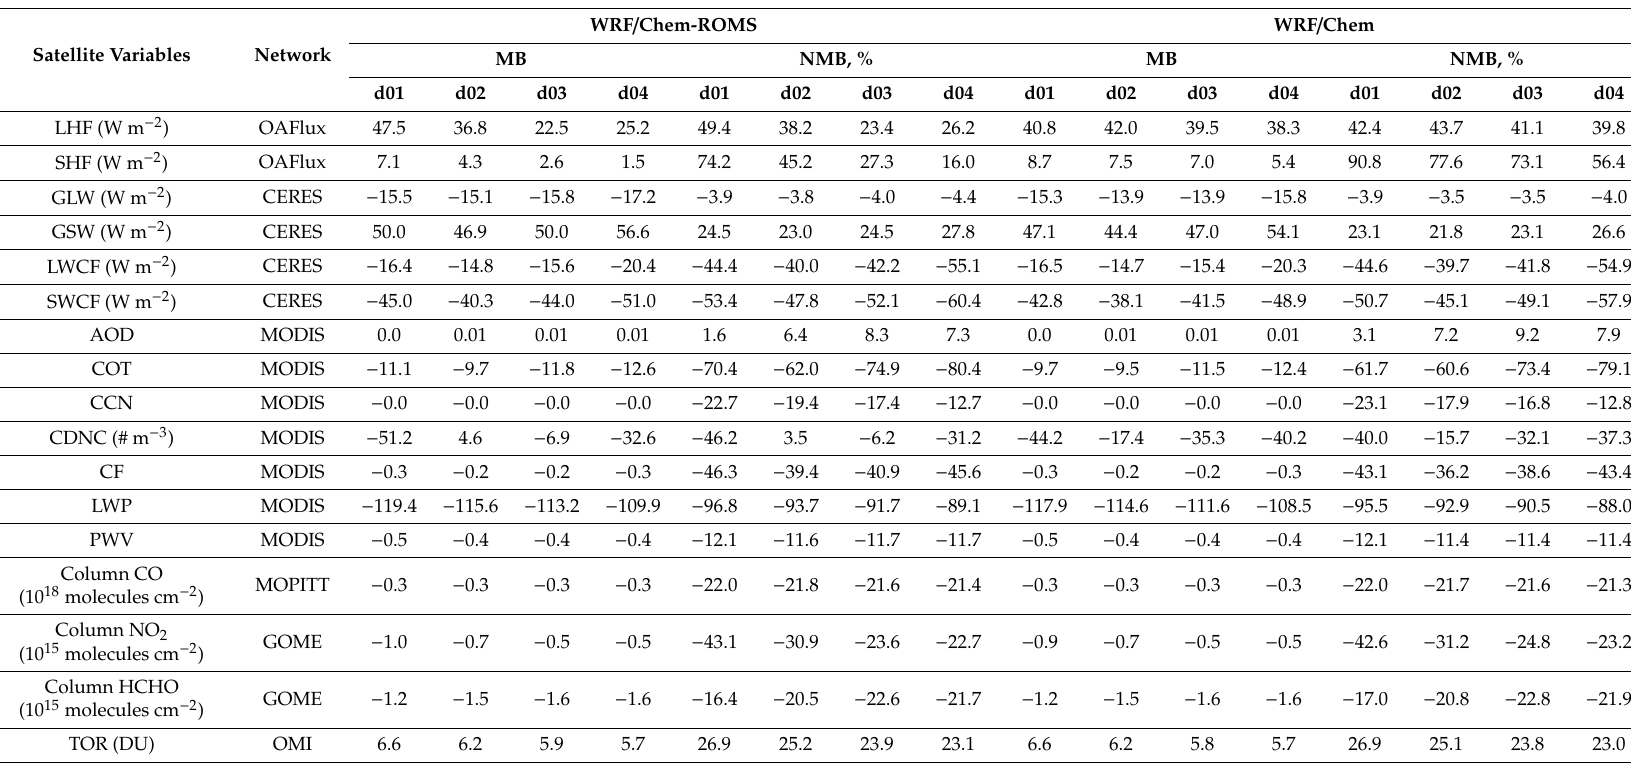
Table 4. Mean bias (MB) and normalized mean bias (NMB) of column variables from WRF / Chem and WRF / Chem-ROMS simulations at 81 km (d01), 27 km (d02), 9 km (d03), and 3 km (d04) over the 3 km domain (d04) for the SPS1 field